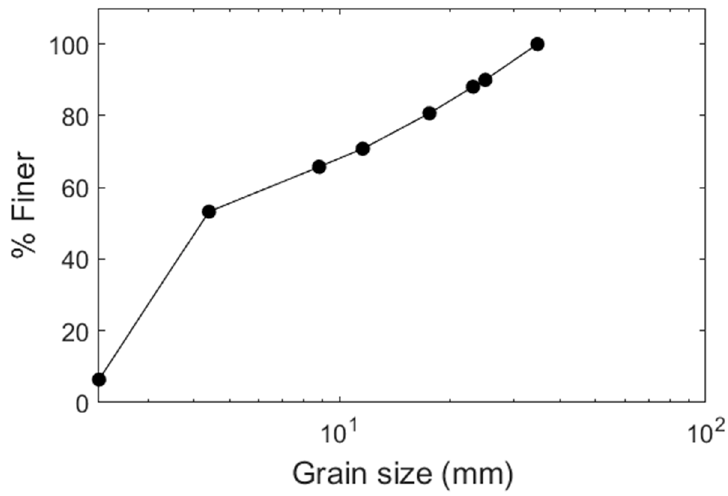
Figure 3. Grain size distribution for Case D.